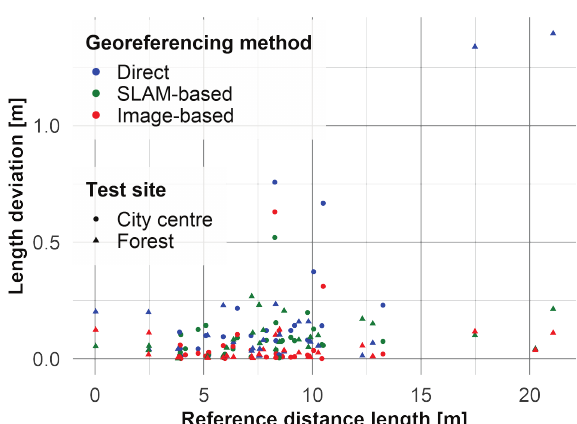
Figure 7. Scatter plot with length deviations between measured 3D distances and ground truth. The colours show the different georeferencing methods, while the point shape represents the test